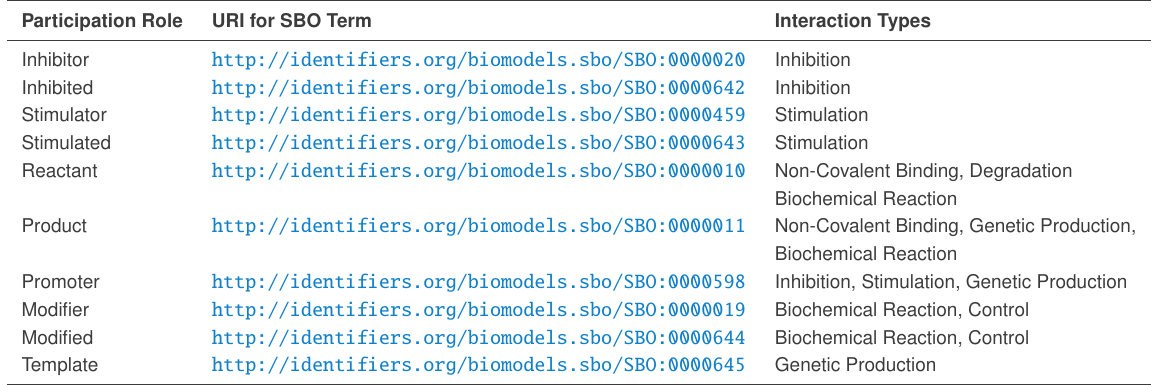
Table 14: SBO terms to specify the roles property of a Participation